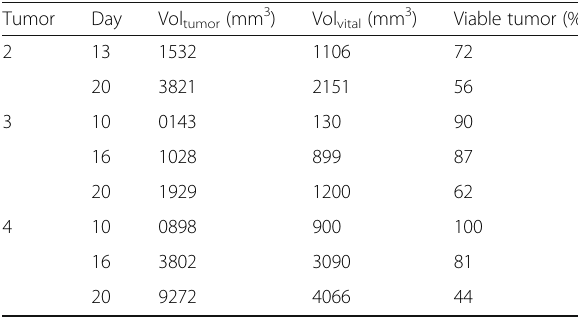
Table 3 Volumetry of FDG-PET in three tumor-bearing rats